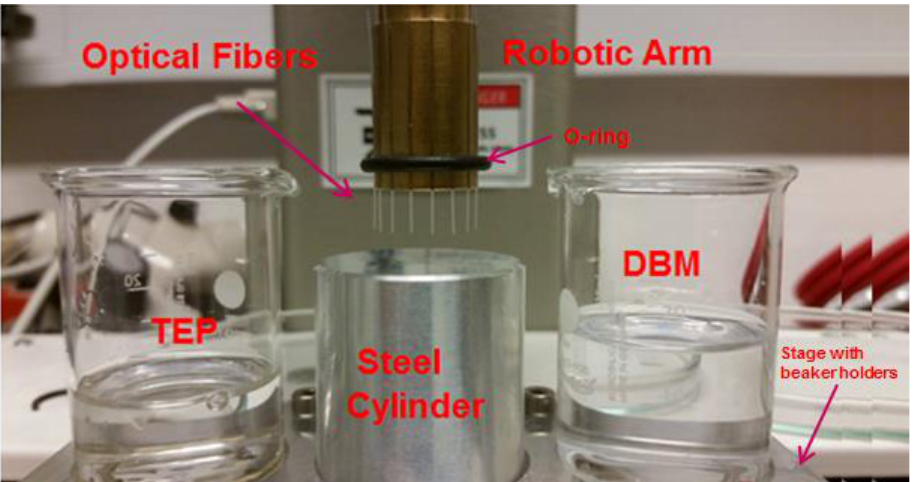
Figure 1. Setup for chemical etching of the fibers for compound parabolic concentrator (CPC) tip formation. The tips are first immersed in dibromomethane (DBM) for etch of the core, then